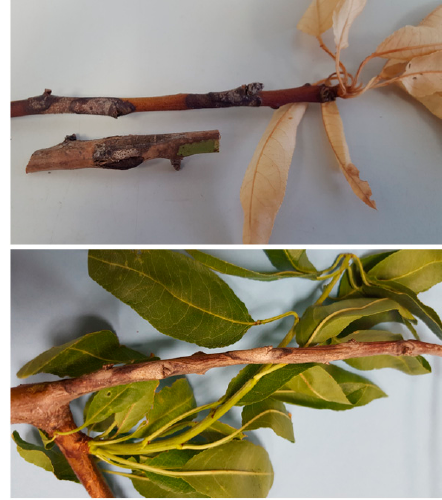
Figure 1. Twig canker and shoot blight symptoms caused by Diaporthe spp. on almond.